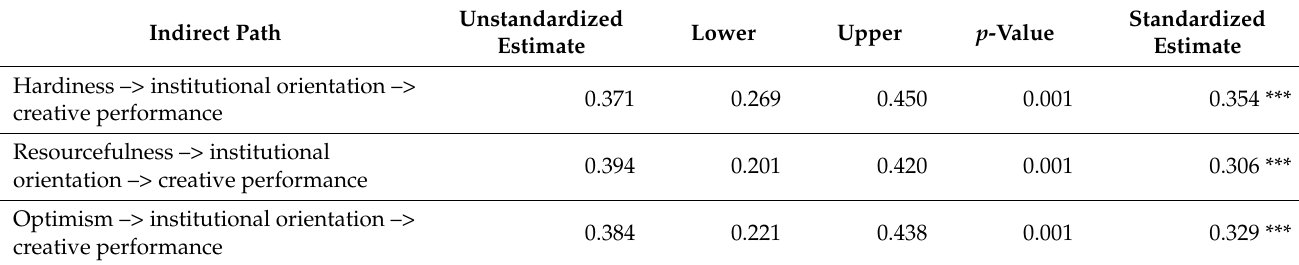
Table 6. Specific indirect estimates calculation from